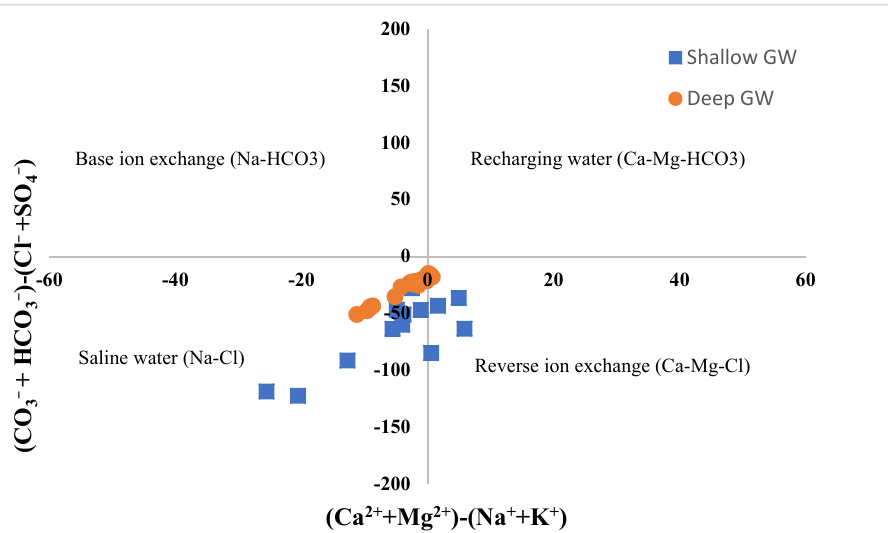
Figure 11. Chadha diagram shows the hydrochemical facies of tested GW samples from shallow and deep aquifers in the study area.